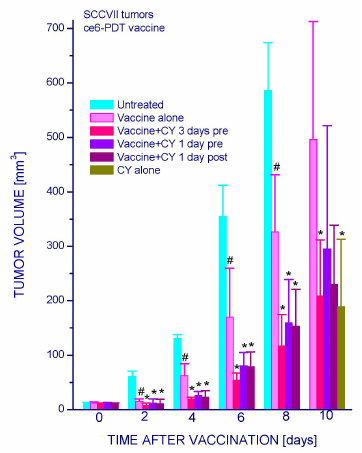
Figure 1. The effect of cyclophosphamide injected either before or after PDT vaccine treatment on growth of vaccinated tumors. Mice bearing subcutaneous SCCVII tumors were injected PDT vaccine cells (2 ˆ 10 7 /mouse peritumorally) and were thereafter monitored for registering tumor growth. Cyclophosphamide (50 mg/kg) was given as a single i.p. injection at either three or one days before or one day after vaccination. Each treatment group consisted of six mice. # Statistically significant difference from untreated tumors group ( p < 0.05); * statistically significant difference from vaccine alone group ( p < 0.05).